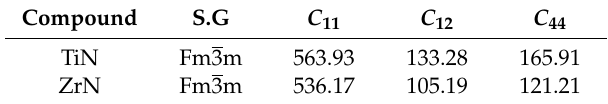
Table 3. Elastic stiffness constants C ij (GPa) of ZrN with space group Fm3m and TiN.